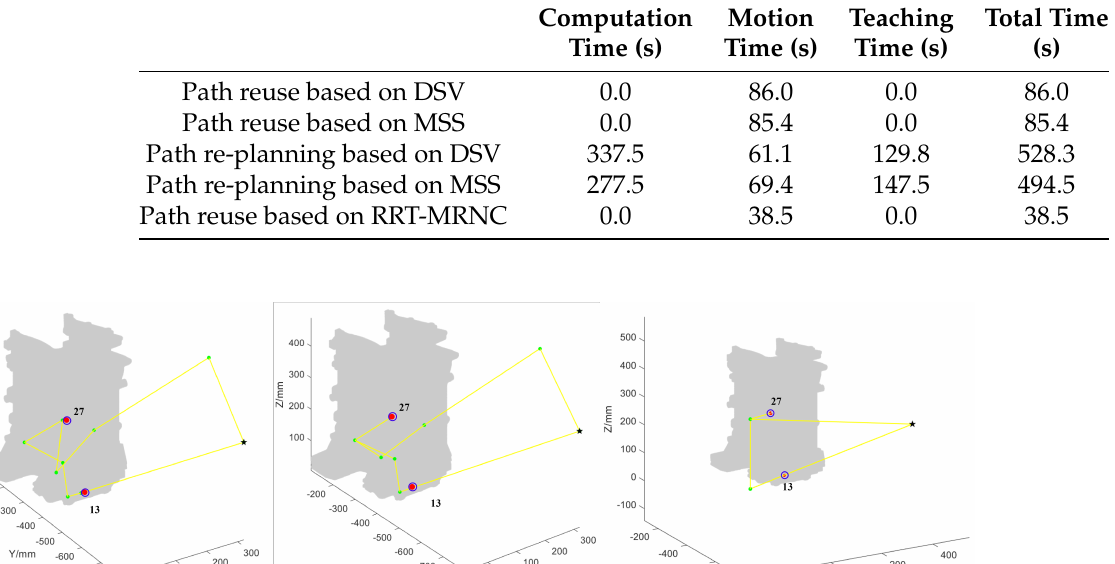
Table 4. Comparison of dynamic task planning results by different methods.